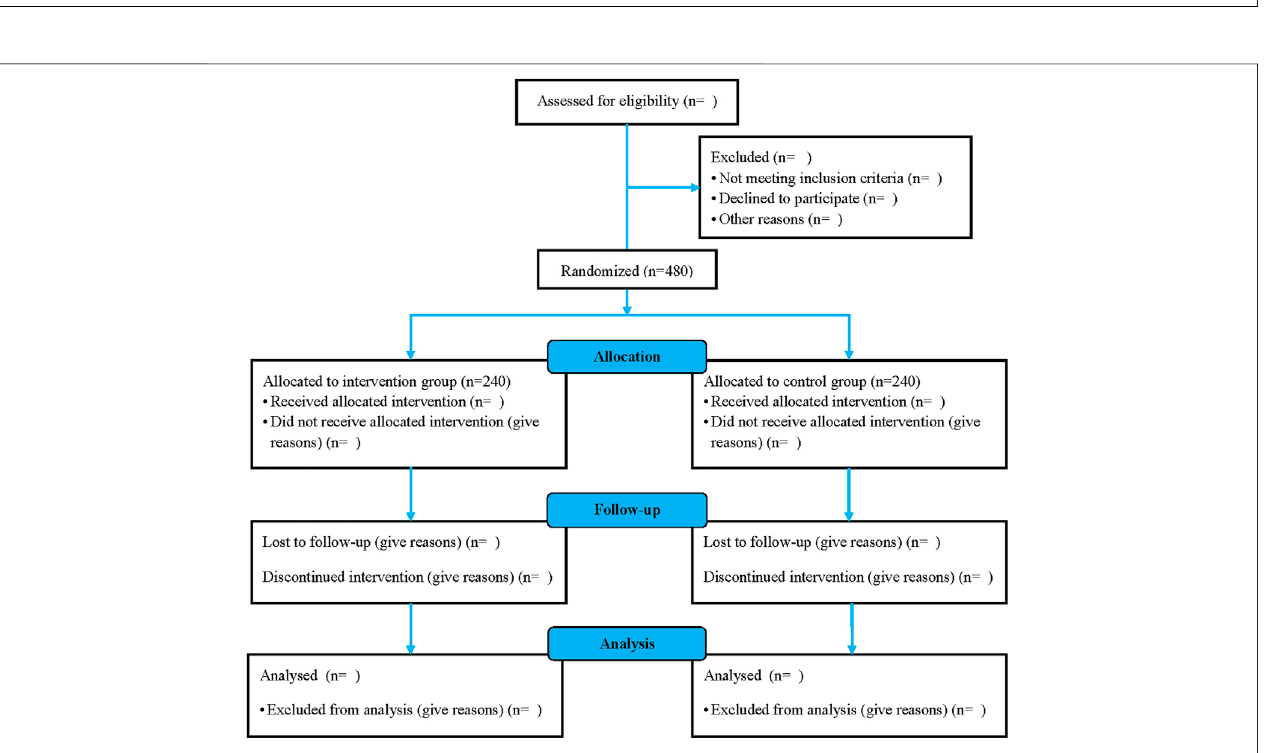
FIGURE 2 | The schematic diagram of the patient